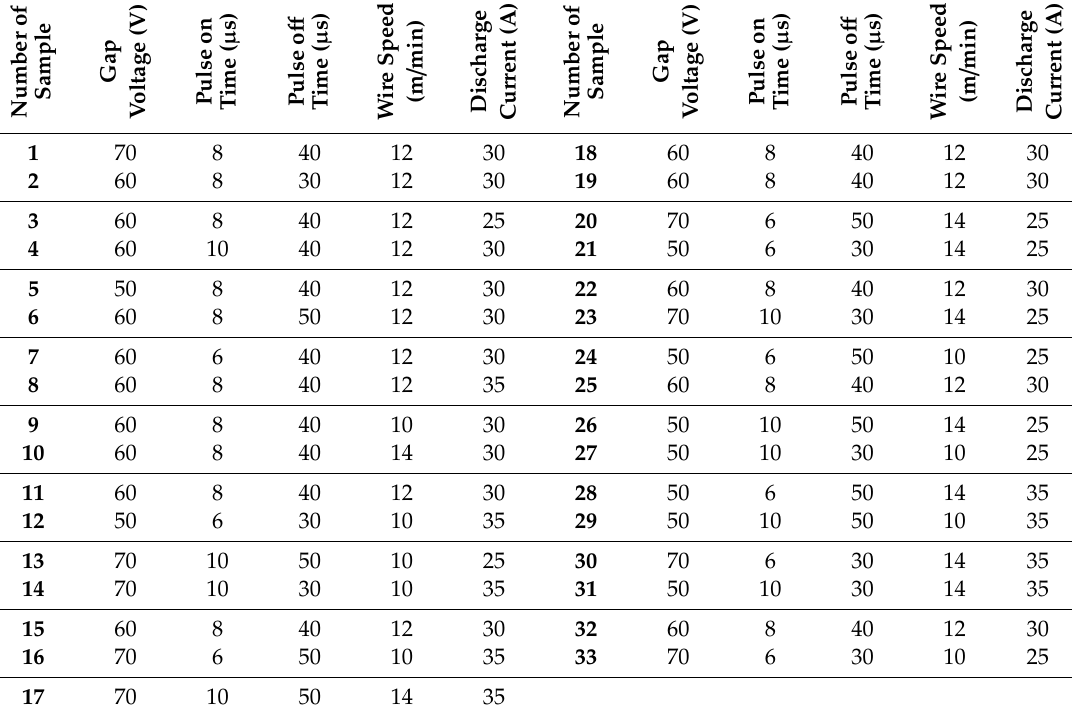
Table 3. Machining parameters used in the experiment and cutting